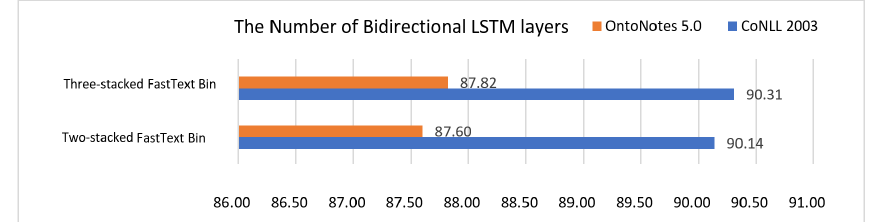
Figure A2. Comparison between two and three stacked bidirectional LSTM CRFs. The results show that three stacked bidirectional LSTM CRFs perform well on both CoNLL 2003 and OntoNotes